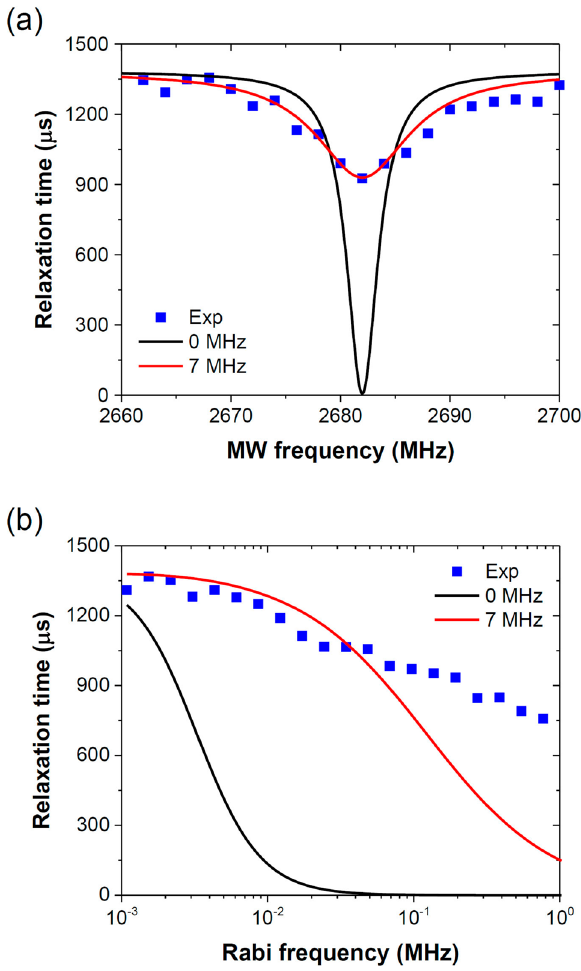
Figure 6. ( a ) Measured and simulated baseline decay time constants as a function of MW frequency at the magnetic field strength of � R / 2 π = 0.061 MHz. ( b ) Measured and simulated baseline decay time constants as a function of MW magnetic field strength ( � R / 2 π ) at the MW frequency of 2682 MHz. Black and red curves in ( a ) and ( b ) are calculated from Eq. (16) with �ω fs / 2 π = 0 and 7